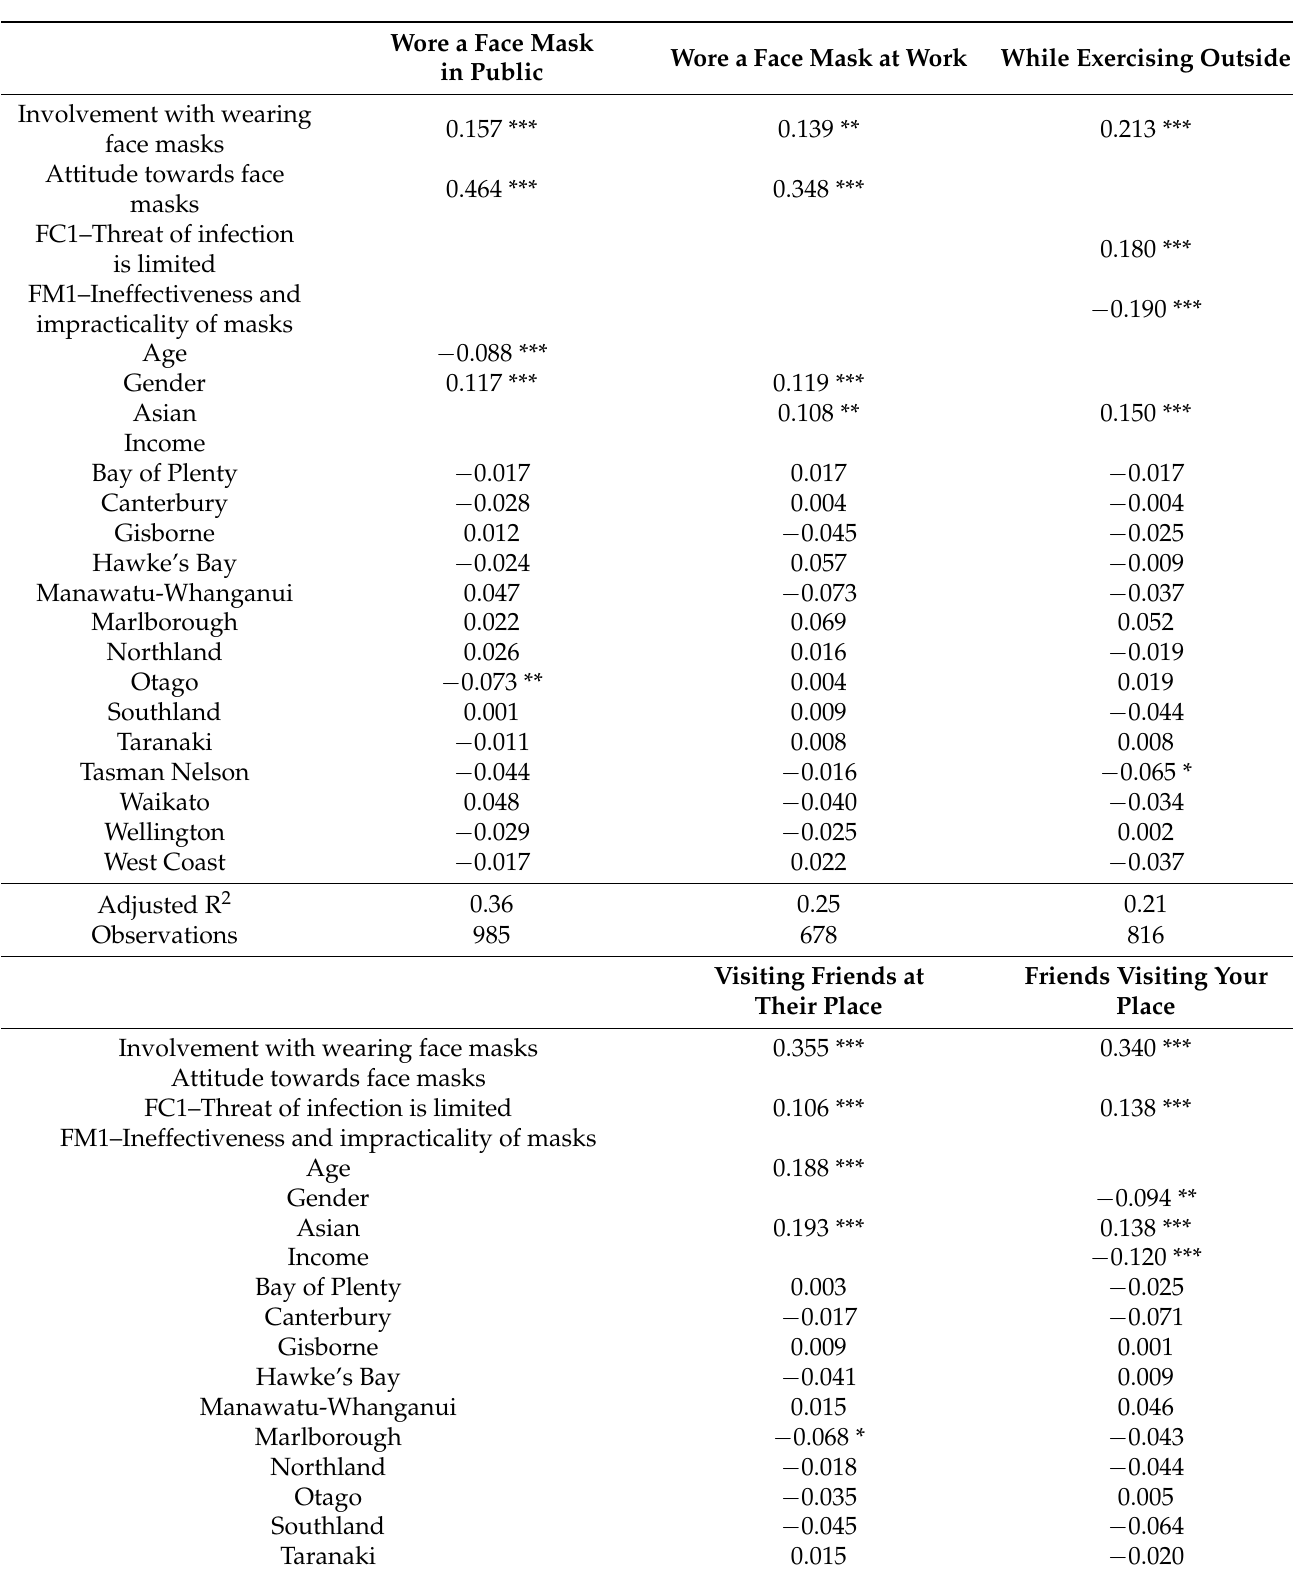
Table A3. Standardised parameter estimates from regressions for wearing face masks with regional dummy